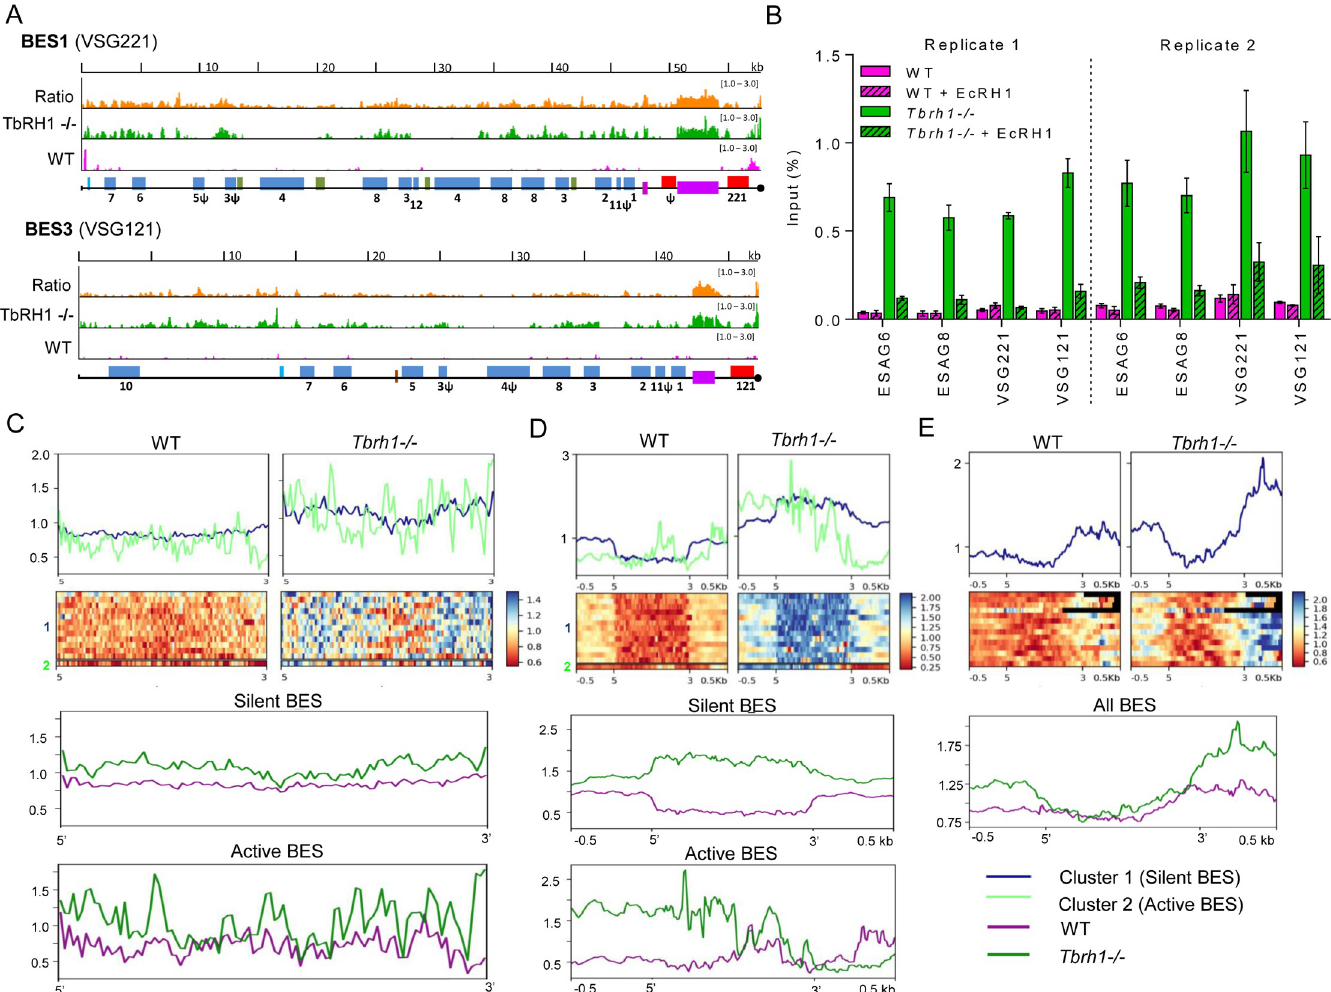
Fig 2. Localisation of R-loops in the Variant Surface Glycoprotein expression sites of T . brucei before after loss of RNase H1. A . Localisation of R-loops by DRIP- seq in wild type (WT) and T . brucei RNase H1 homozygous mutant ( Tbrh1-/- ) bloodstream form cells. DRIP-seq signal is shown mapped to BES1 (the predominantly active VSG expression site (ES) of WT cells) and BES3 (which is mainly inactive); general structural organisation of the T . brucei BES is summarised in Fig 5. Pink and green tracks show normalised ratios of read-depth fold-change (1–3 fold) in IP samples relative to input in WT and Tbrh1 -/- mutants, respectively, while the orange tracks show the ratio of IP enrichment in Tbrh1-/- cells compared with WT. Promoters (aqua), ESAG s (blue, numbered), 70-bp repeats (purple) and VSG s (red) are annotated as boxes; pseudogenes are indicated ( ψ ), hypothetical genes are shown in green, and the end of the available ES sequence is denoted by a black circle. B . DRIP- qPCR, with or without E . coli RNase H1 (EcRH1) treatment, showing the percentage of PCR amplification in the IP sample relative to input for WT cells (pink) and Tbrh1 -/- mutants (green); error bars display SEM for at least three technical replicates and data are shown for two biological replicates (1 and 2). C-E . DRIP-seq signal fold-change (IP relative to input samples) is shown on the y-axes, plotted as heatmaps and average signal fold-change profiles over ES regions encompassing the ESAG s (C), 70-bp repeats (D) and VSG (E); for each region, 5’ and 3’ (x-axes) denote the upstream and downstream boundaries, and in some cases -/+ 0.5 kb of flanking sequence is shown. Upper two panels: comparison of WT and Tbrh1-/- DRIP-seq signal using K-means clustering, which separated the active (light green, cluster 2) and inactive (dark blue, cluster 1) ES when analysing ESAG s and 70 bp repeats, but not VSG s. Lower panels: Overlay of WT (purple) and Tbrh1-/- (green) DRIP-seq signals in the three ES regions, with the active and silent ES displayed separately for the ESAG s and 70 bp